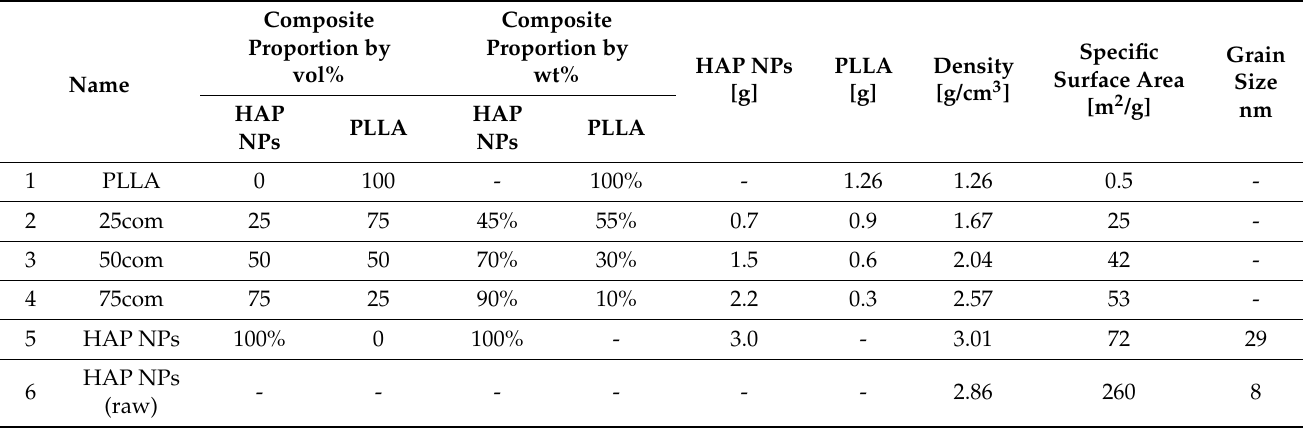
Table 1. Physical properties of PLLA, HAP NPs (raw), HAP NPs (heated at 600 ◦ ) components and 25com, 50com, and 75com